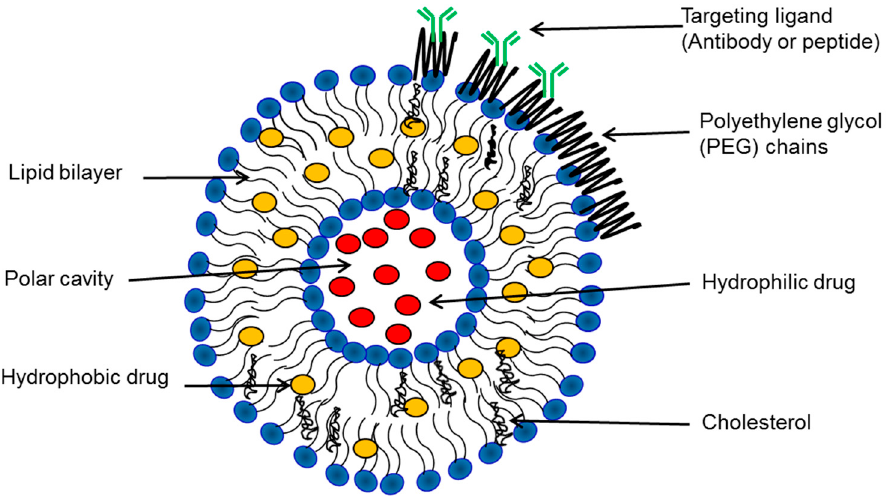
Figure 2. Schematic of liposomes and their different components.